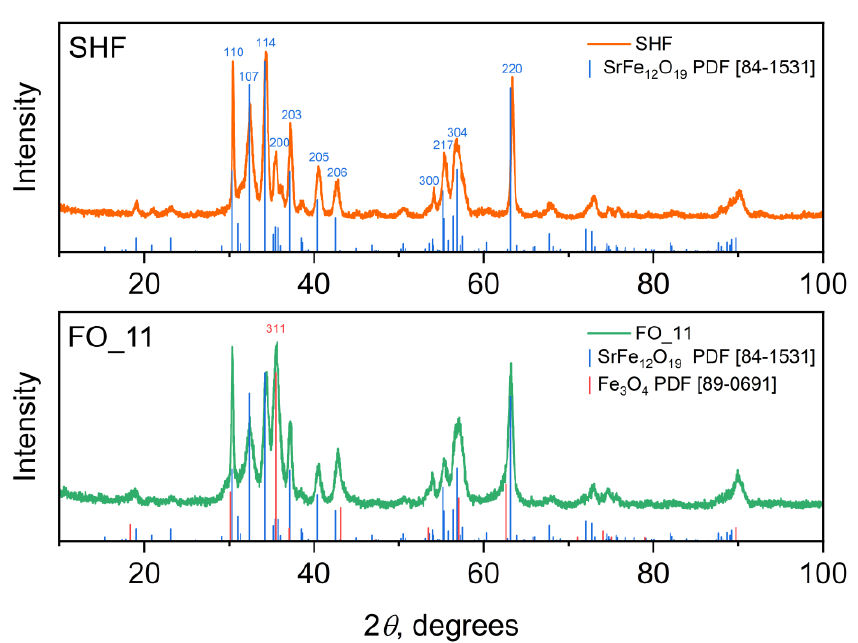
Figure A1. XRD patterns of SHF and FO_11 samples. Royal blue and coral columns represent hexaferrite and magnetite reflections. Note that only (311) Fe 3 O 4 line does not coinside hexaferrite peaks.